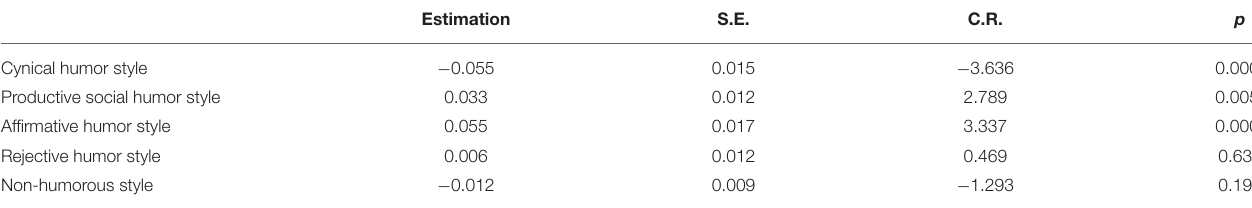
TABLE 5 | Regression results on the effect of teachers’ views on the humor behaviors of school principals on organizational